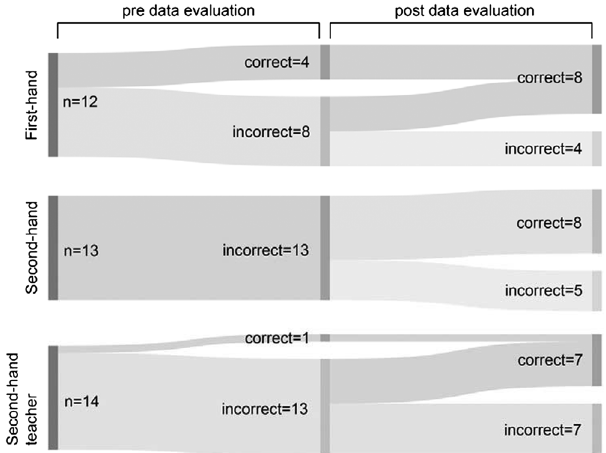
FIG. 1. Number of students with a correct hypothesis or one of the incorrect hypotheses in the pretest and the post-test for the three